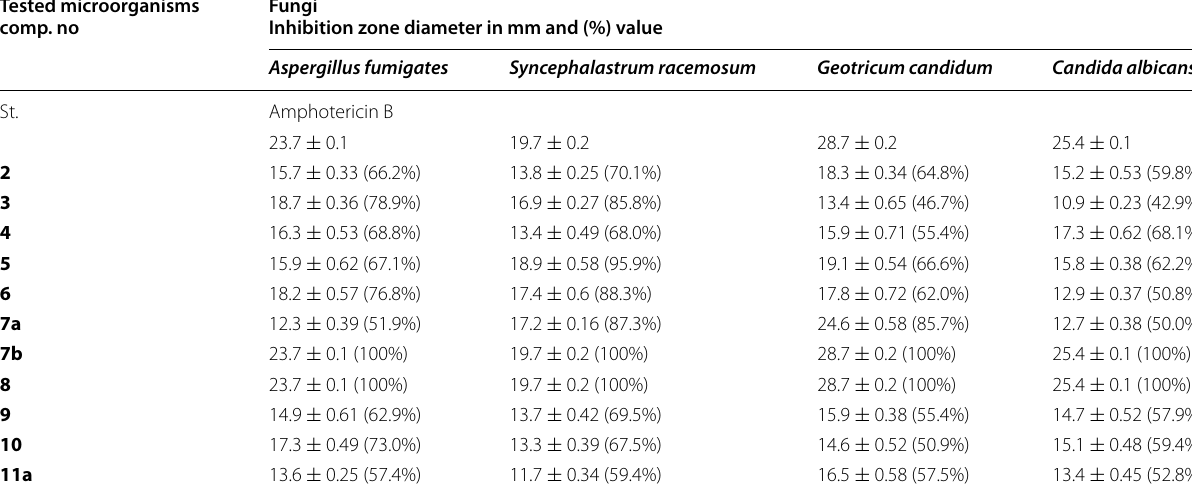
Table 2 Antifungal activity of synthesized compound (zone of inhibition in diameter in mm) Tested microorganisms comp.